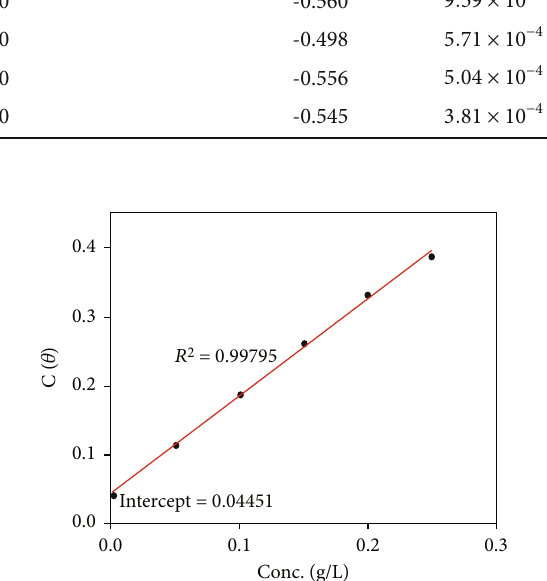
Figure 7: Linearized Langmuir adsorption isotherm plots of mild steel in 1N